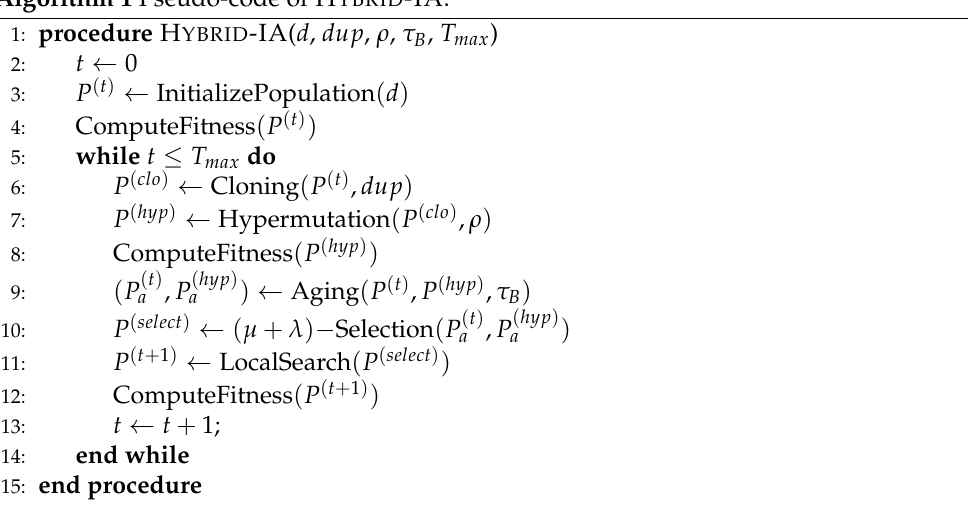
Algorithm 1 Pseudo-code of H YBRID